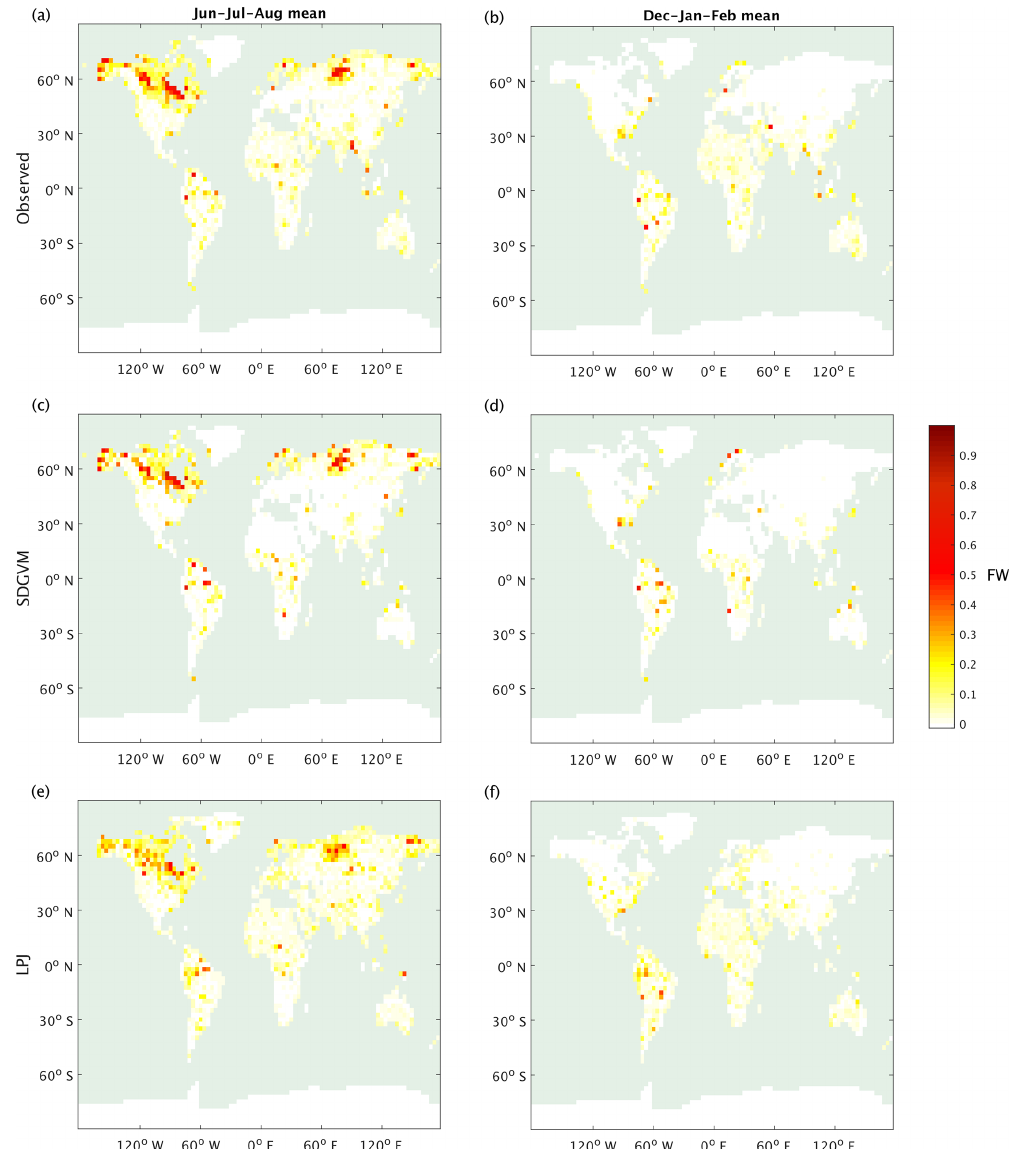
Figure 2. Seasonal mean FW: observed interpolated to model grid; (a) June–July–August and (b) December–January–February. The 1NN prediction by SDGVM (c) June–July–August and (d) December–January–February. The 1NN prediction by LPJ (e) June–July–August and (f)